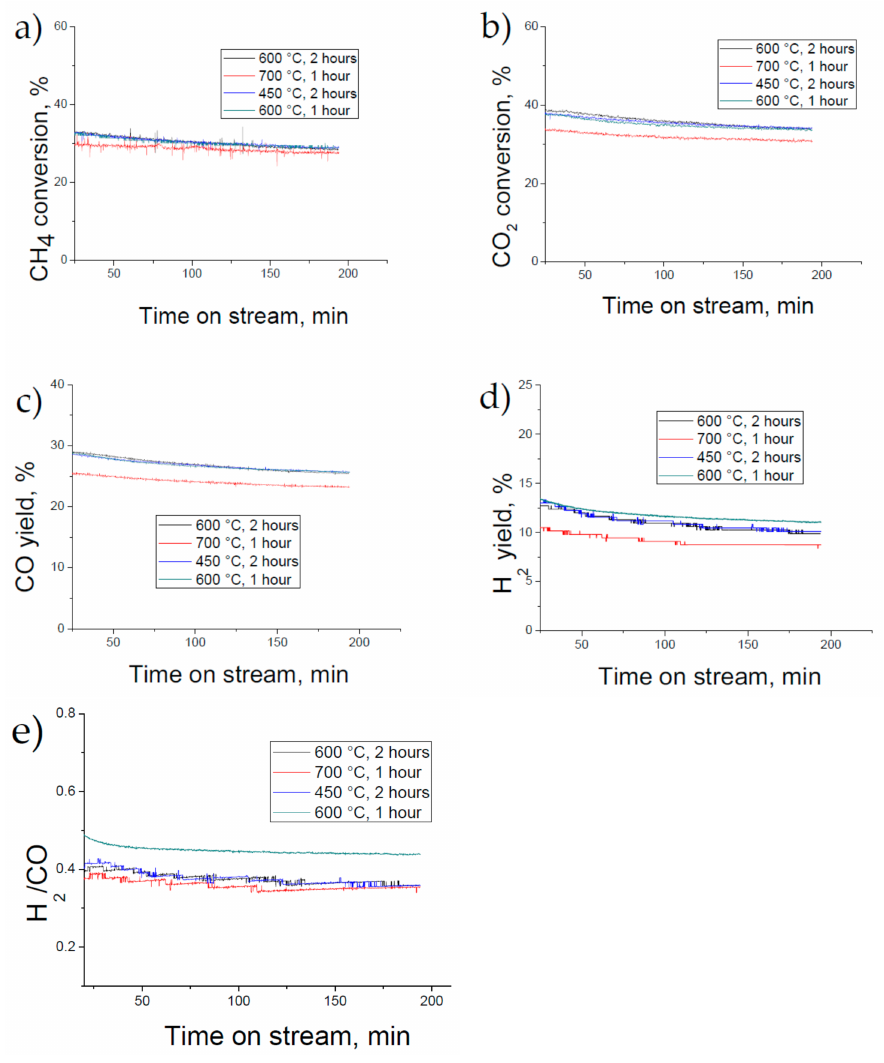
Figure 5. The effect of NiCeTiNbZr-I sample reduction conditions (given in insets) on ( a ) CH 4 conversion, ( b ) CO 2 conversion, ( c ) CO yield, ( d ) H 2 yield, ( e ) H 2 /CO ratio. DRM reaction conditions: 700 ◦ C, contact time 7.5 ms, initial reaction mixture 15% CH 4 + 15% CO 2 + N 2